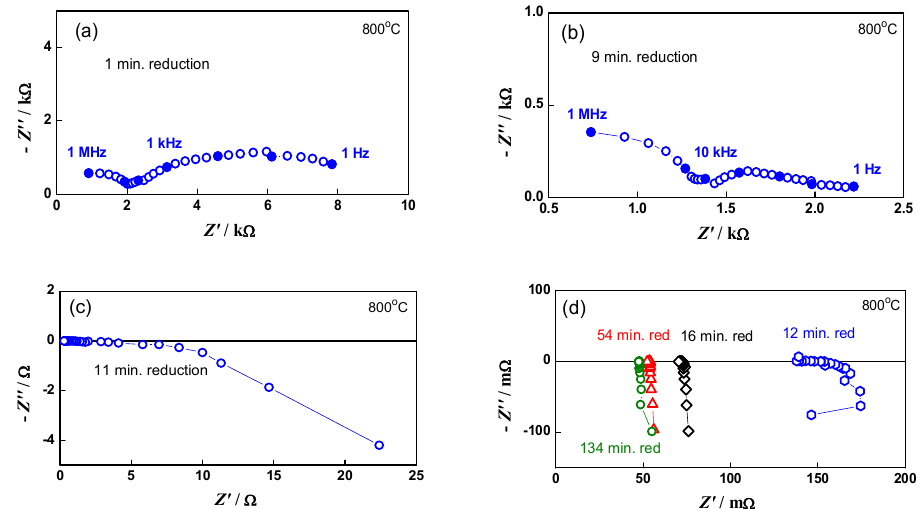
Figure 1. Impedance diagrams in different steps of the initial bare anode reduction: ( a ) impedance diagram during the first minute of the reduction; ( b ) impedance diagram during the ninth minute of the reduction; ( c ) impedance diagram during the eleventh minute of the reduction; ( d ) comparison of impedance diagrams at different stages of the reduction-from the twelfth minute to the end of the reduction process.